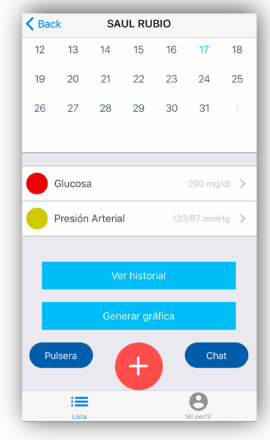
Figure 5. Medical record.